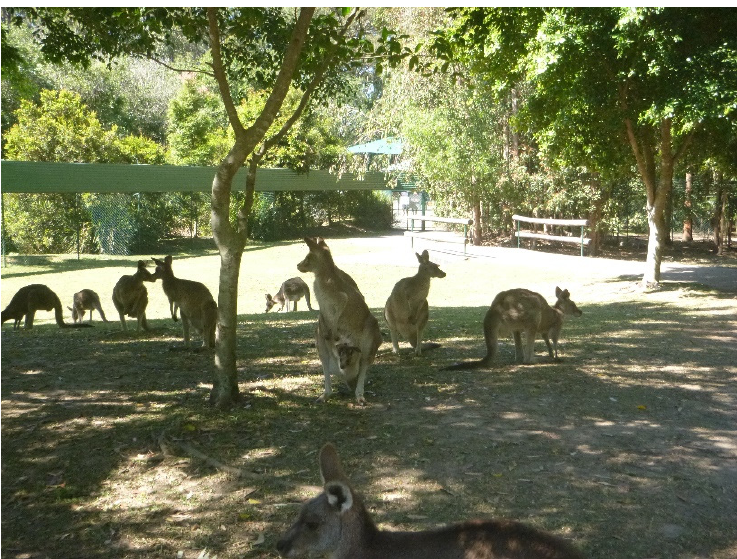
Figure 5. Maintaining a positive outlook: Sunny climate suggests nature promotes positivity.